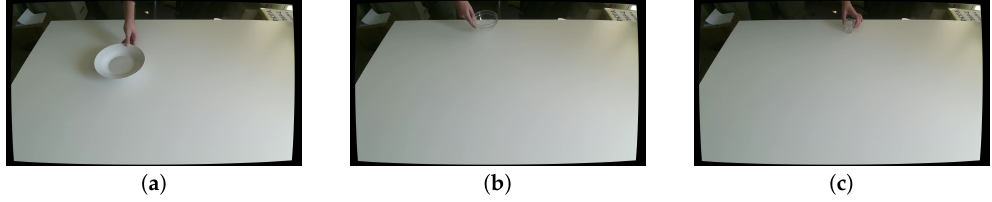
Figure 6. The objects that were utilized for the optical flow experiment: ( a ) plate, ( b ) glass bowl, ( c ) plastic cup.